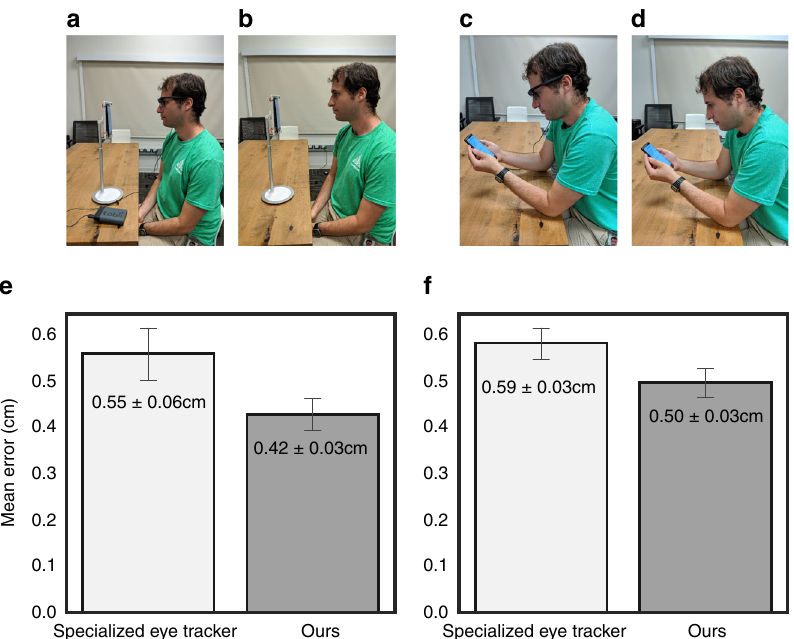
Fig. 2 Comparison between accuracy of Tobii glasses vs. our model. Study setup shows the four experimental conditions: Participant (an author for visualization purposes) views stimuli on the phone (mounted on a device stand) while wearing Tobii glasses ( a ) and without ( b ). c , d Similar to the above, but participant holds the phone in the hand. e , f Accuracy of specialized eye tracker (Tobii glasses) vs. our smartphone eye tracker (mean ± s.e.m., n = 13 participants) for the device stand and hand-held settings. Statistical comparison shows no signi fi cant difference in accuracy across both settings (device stand: t(12) = − 2.12, p = 0.06; hand-held: t(12) = − 1.53, p = 0.15; two-tailed paired t -test).